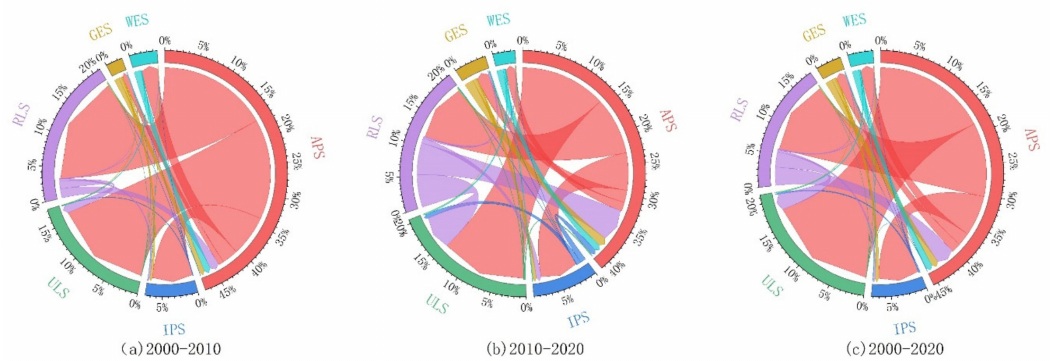
Figure 5. Land use change transition matrix from year in 2000–2010 ( a ), 2010–2020 ( b ), and 2000–2020 ( c ) (unit: km 2 ).